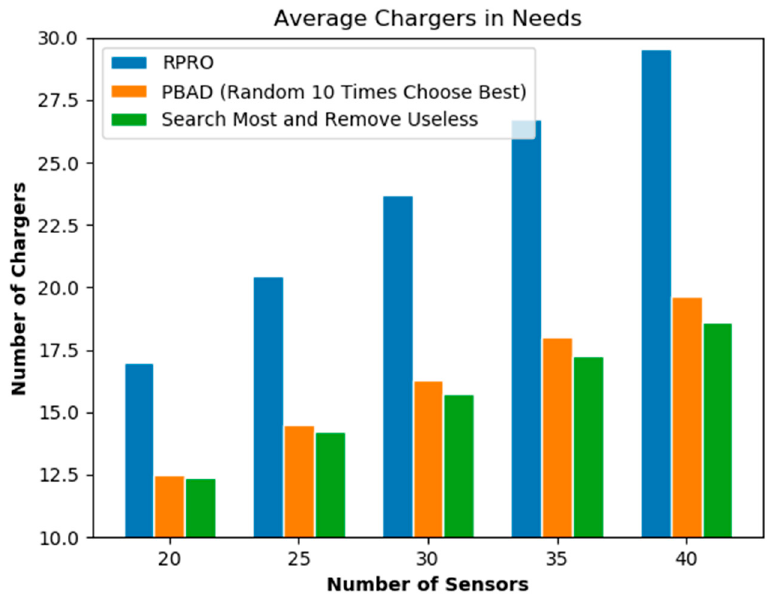
Figure 7. The average number of chargers.